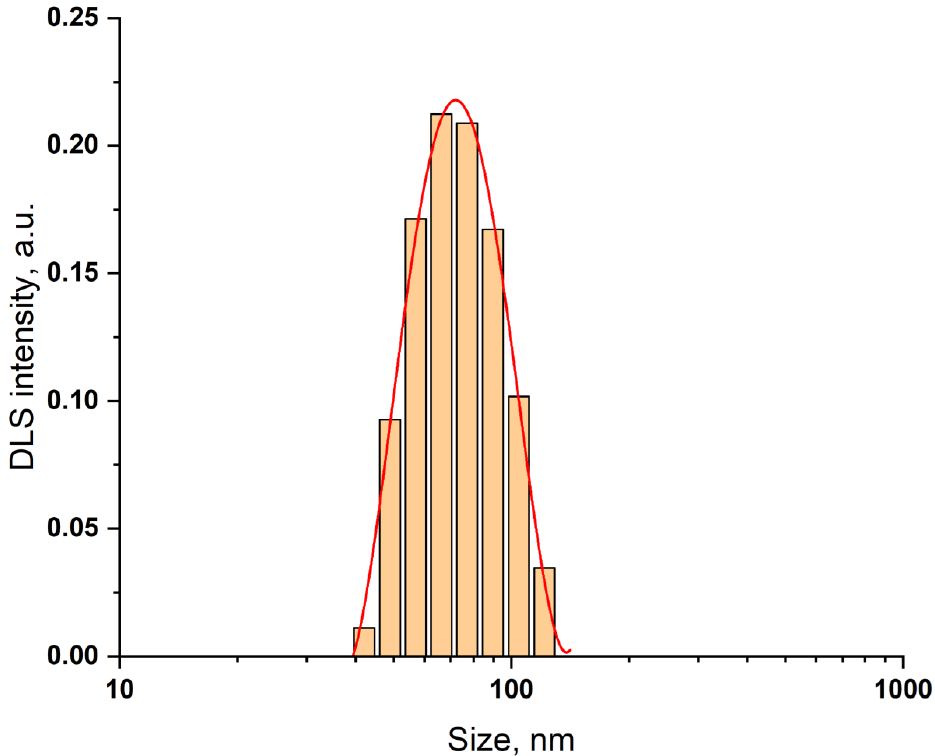
Figure 1. Size distribution of CuO NPs determined by DLS. Table 1. NAC significantly enhances the cytotoxicity of CuO